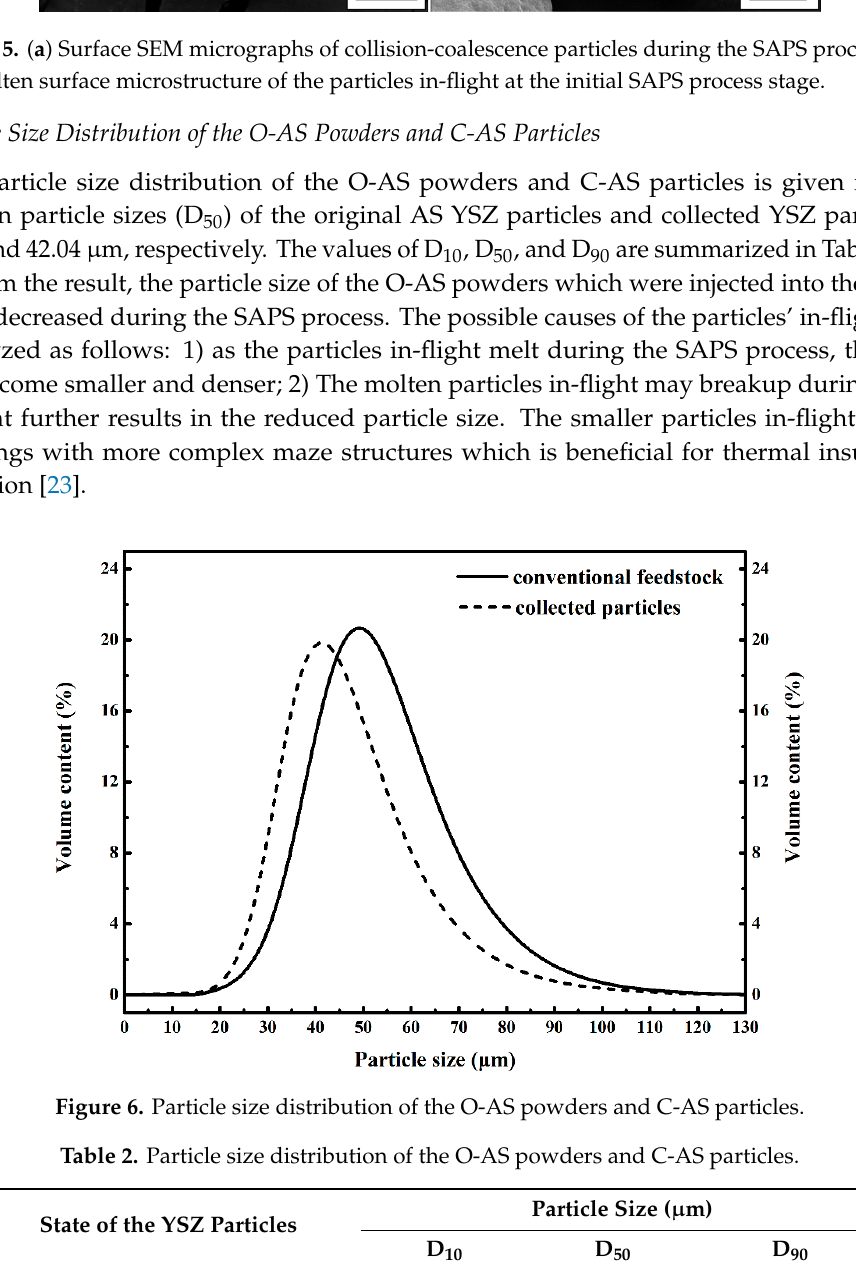
Figure 5. ( a ) Surface SEM micrographs of collision-coalescence particles during the SAPS process and ( b ) molten surface microstructure of the particles in-flight at the initial SAPS process stage.